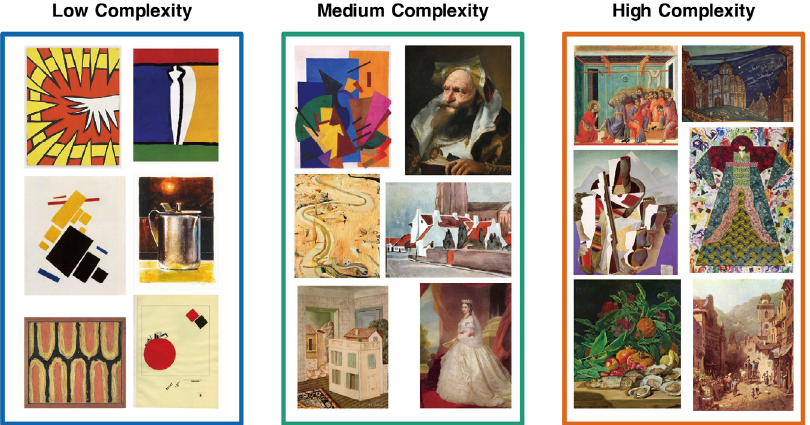
Figure 1. Examples of stimuli under low-, medium-, and high-complexity conditions. A total of 254 images were used for the experiment. For the low-complexity condition group, the complexity score range was 1–33, the medium-complexity condition group score range was 34–66, and the high-complexity condition group score range was 67–100.